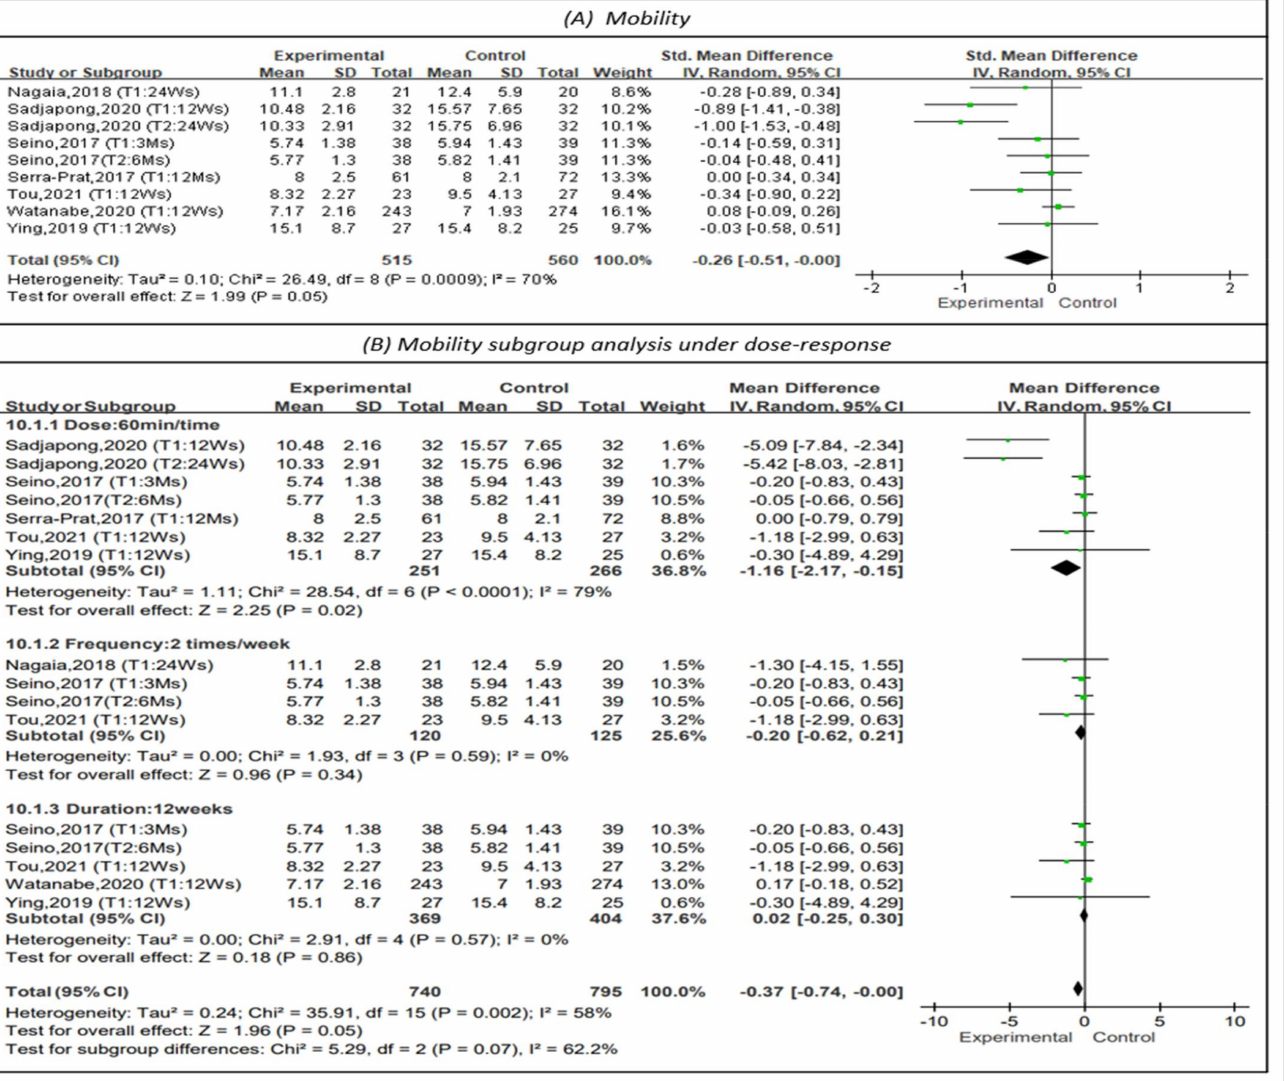
Figure 8. Forest plot of effects on mobility and subgroup analysis for dose-response. The size of the green square represents the weight of the study in the meta-analysis. The rhombus represents the combined OR. OR = odds